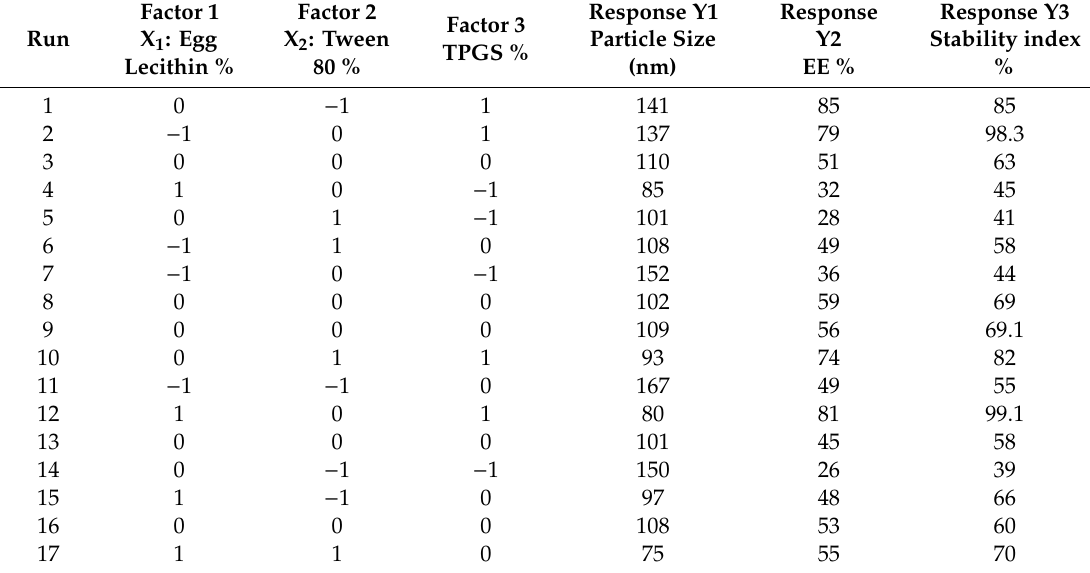
Table 3. NTS (nanotransfersomes) formulation compositions with their observed responses.